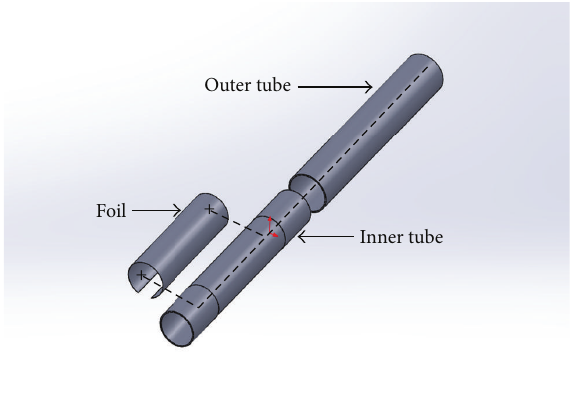
Figure 1: Exploded view of the target assembly.